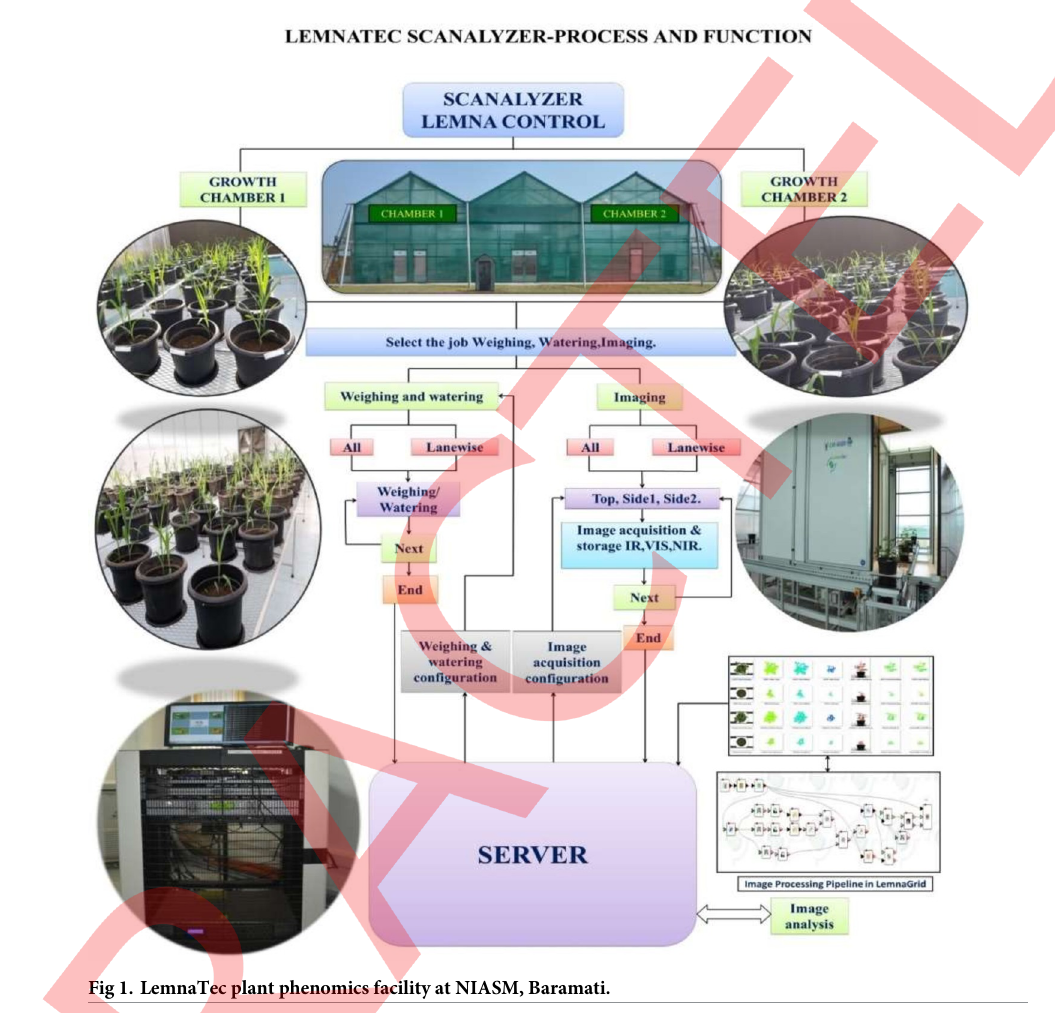
Fig 1. LemnaTec plant phenomics facility at NIASM,